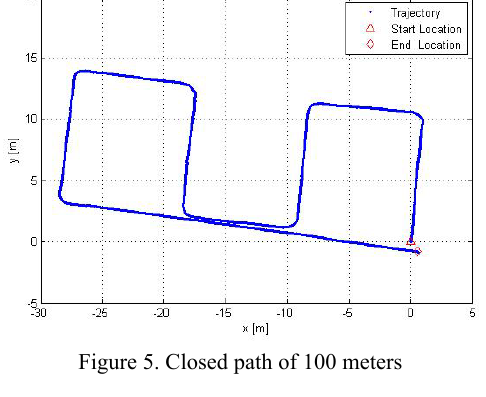
Figure 5. Closed path of 100 meters